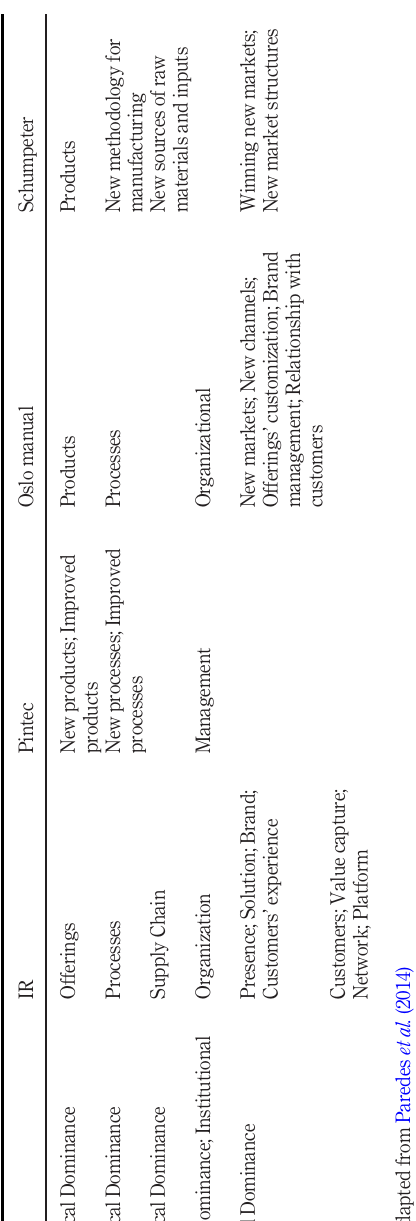
Table III. Dimensions of innovation models: a